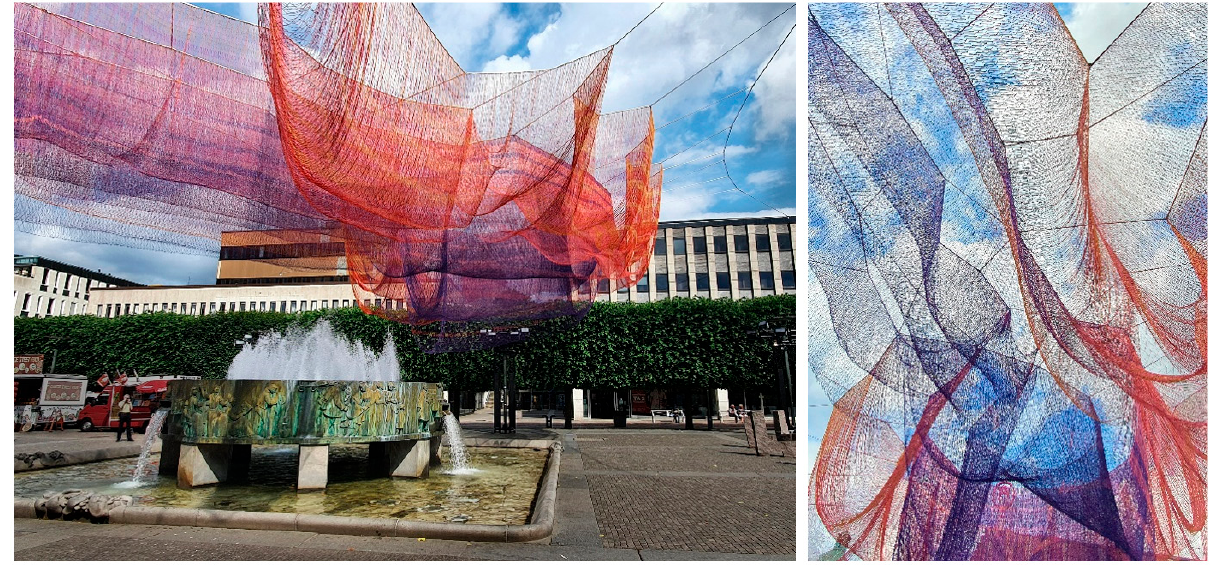
Figure 1. Janet Echelman’s sculpture 1.78 Borås.